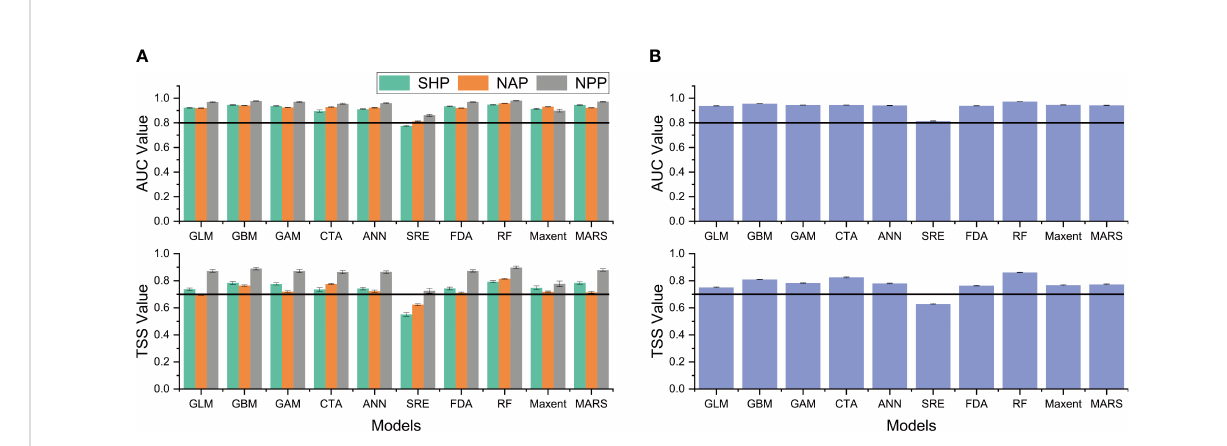
FIGURE 3 Predictive ability of the ten modeling algorithms estimated by the true skill statistics (TSS) and the area under the receiver operating characteristic curve (AUC) built at the population level (A) and species level (B) . The black horizontal lines indicate the cutoff values of the AUC (0.8) and TSS (0.7) of the single model used to build the ensemble